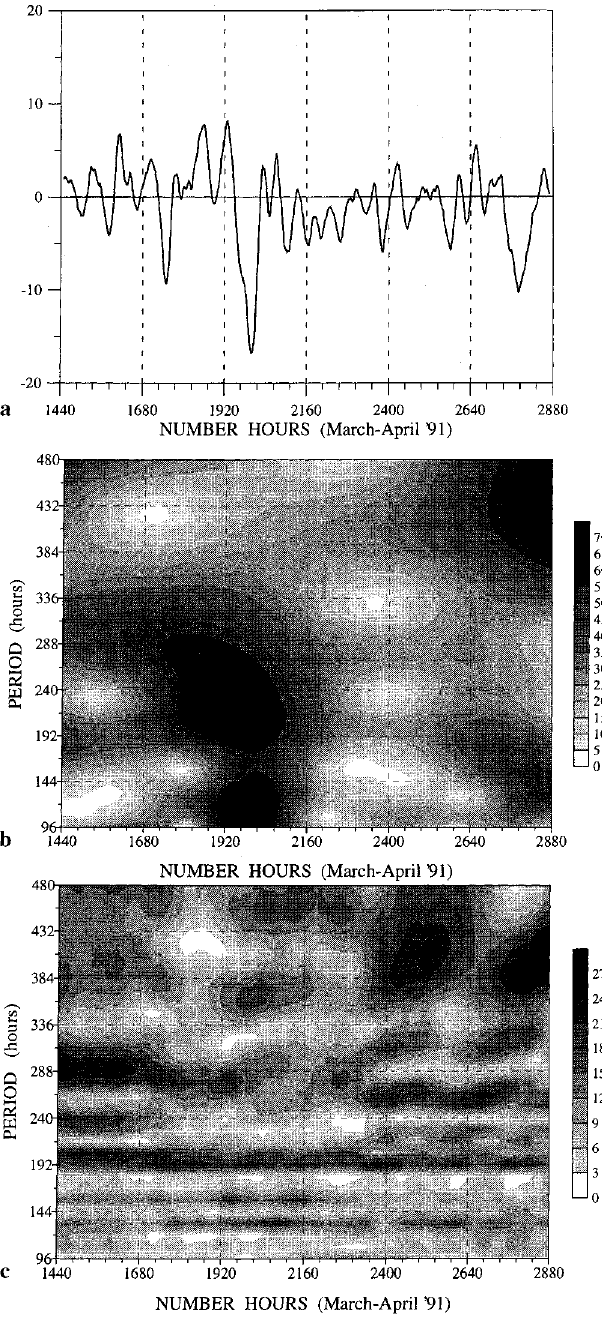
Fig. 8. a The hourly values of zonal neutral wind measured by meteor radar in the MLT region above Bulgaria in March–April, 1991. b The Morlet wavelet transform of the zonal neutral wind, shown in a . c The short-time Fourier transform with the length of the segment 60 days which is incremented in steps of 1 h, applied to the same zonal neutral